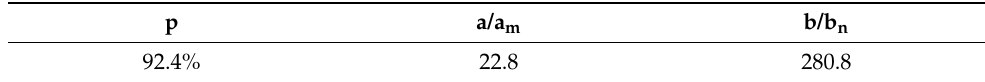
Table 10. Degree of stuck pipe for well N.